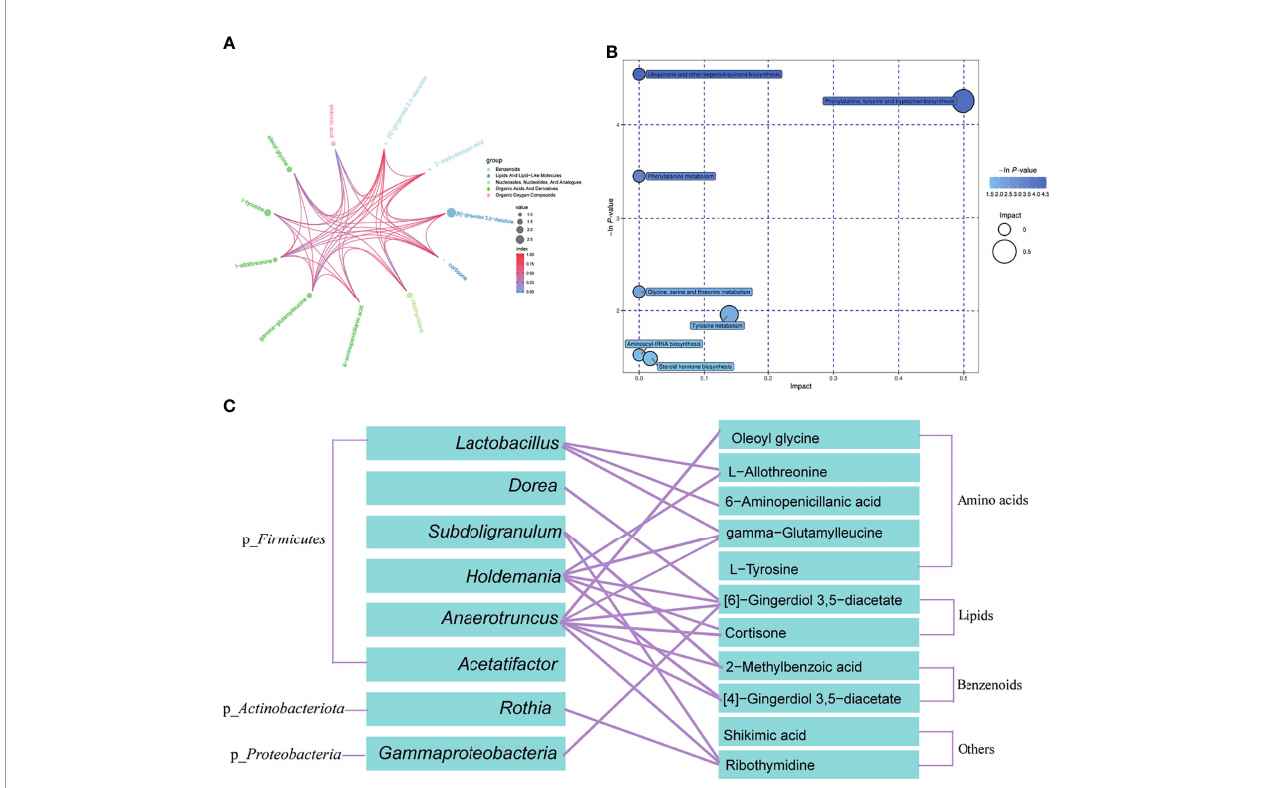
FIGURE 6 | Correlation Analysis and Differential Metabolic Pathway enrichment. (A) Chord analysis of differential metabolites between the Sive and CLP groups was used to visualize the relationship between substance classi fi cation and content variation. (B) Pathway enrichment and statistical signi fi cance of differential metabolites between the Sive and CLP groups. (C) Correlation analysis of differential bacterial genera and metabolites between the Sive and CLP